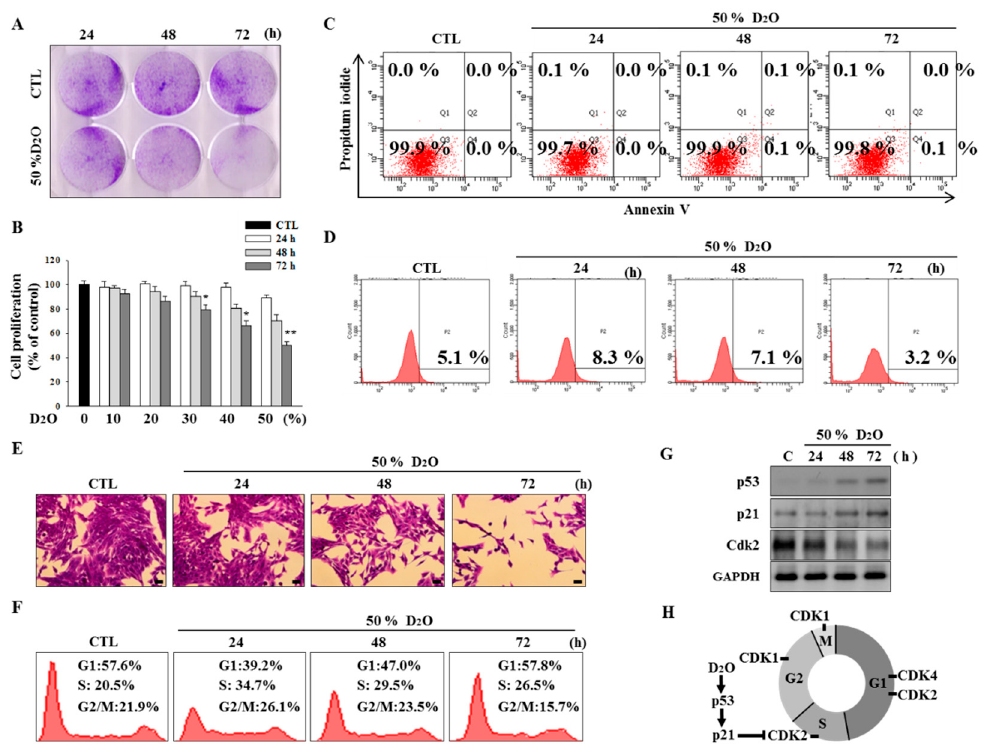
Figure 1. Deuterium oxide (D 2 O) inhibited the proliferation of activated hepatic stellate cells (HSCs). HSC-T6 cells were treated with 50% D 2 O for 24, 48, and 72 h ( A ). The cells were then stained with 0.5% crystal violet and were visualized by photography ( B ). The stained cells were rinsed with dimethyl sulfoxide (DMSO), and absorbance at 570 nm due to the crystal violet staining was measured. The D 2 O-treated HSC cells were stained with Annexin V and propidium iodide (PI), and flow cytometry was performed to determine the degree of apoptosis ( C ). The lower right quadrant (annexin V + /propidium iodide [PI] − ) and upper right quadrant (annexin V + /PI + ) represent the percentage of cells in early and late apoptosis, respectively. To measure intracellular reactive oxygen species (ROS) levels, dichlorodihydrofluorescein diacetate (DCFDA; 20 µ M) was added after harvesting of HSCs exposed to 50% D 2 O ( D ). The morphology of stained HSCs was examined by microscopy (scale bar, 100 µ m) ( E ). A flow-cytometric analysis of the cell cycle using PI was performed ( F ). The expression levels of p53, p21, and CDK2 were evaluated by western blotting ( G ). GAPDH served as a loading control. A proposed scheme illustrating the mechanism by which D 2 O arrests cells in the S phase via downregulation of aquaporin (AQP) 11 ( H ). ** p < 0.01 or * p < 0.05 as compared with the control. Data are presented as mean ± SD (n = 3).